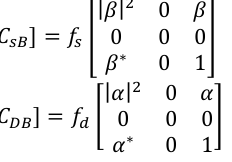
Figure 1: Three scattering mechanisms (Mette 2007) In the scattering model decomposition, the covariance matrix estimated by the PolSAR data is often used (Yamada, Onoda et al. 2008), which is defined by Equation